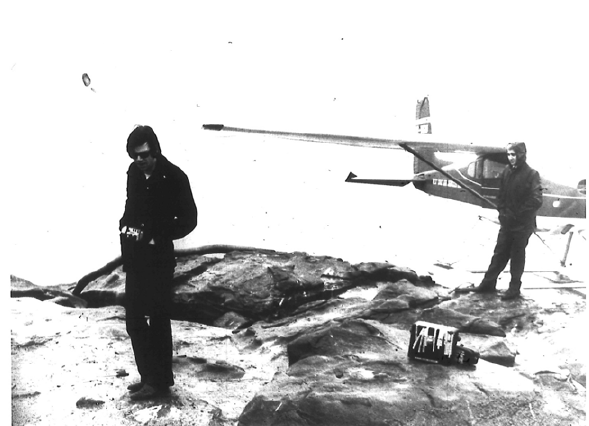
Figure 8. Robert Smithson preparing to take aerial pictures of Spiral Jetty in Salt Lake, Utah, 1970